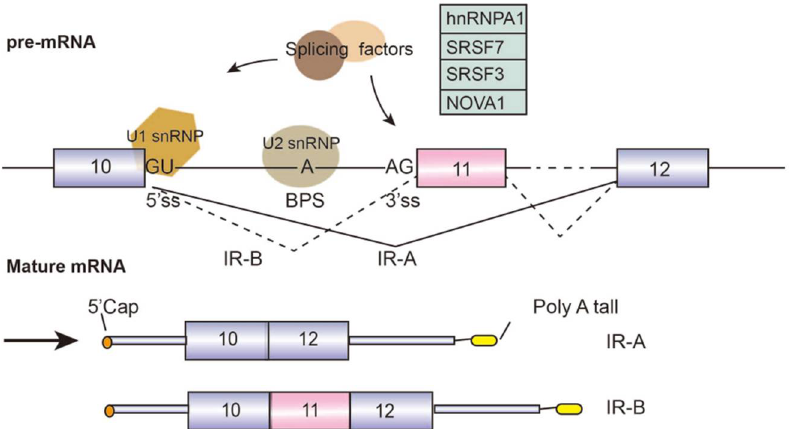
Figure 4. Graphical representation of assembly of alternative splicing factors (hnRNPA1, SRSF7, SRSF3, and NOVA1) on the INSR pre-mRNA and insulin receptor (IR) splice variants. Splicing factors are listed in the green box. Alternative splicing sites are connected by dashed lines. The boxes represent exons and the lines represent introns.